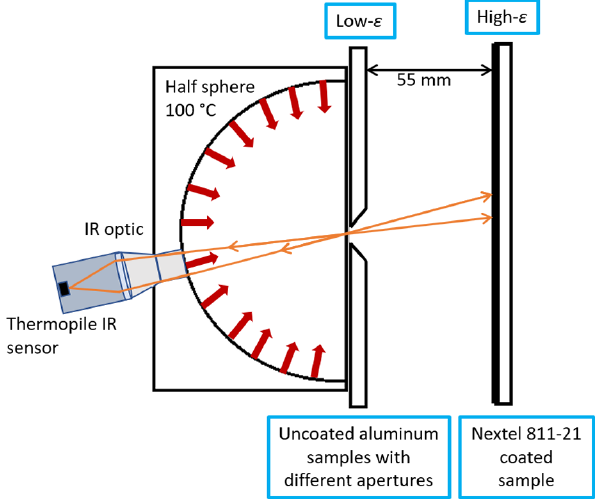
Figure 3. Principle of the measurement field size determination of the TIR 100-2 with the varied aperture method. Side view.